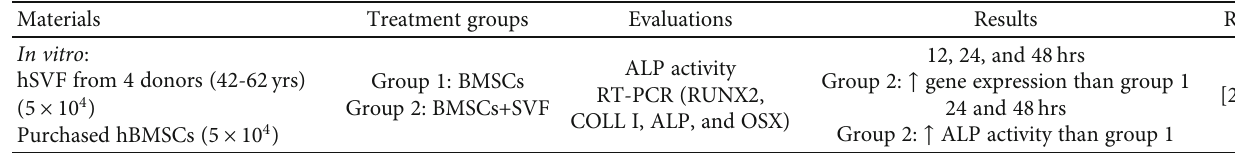
Table 1: In vitro , in vivo , and clinical studies on SVF in bone